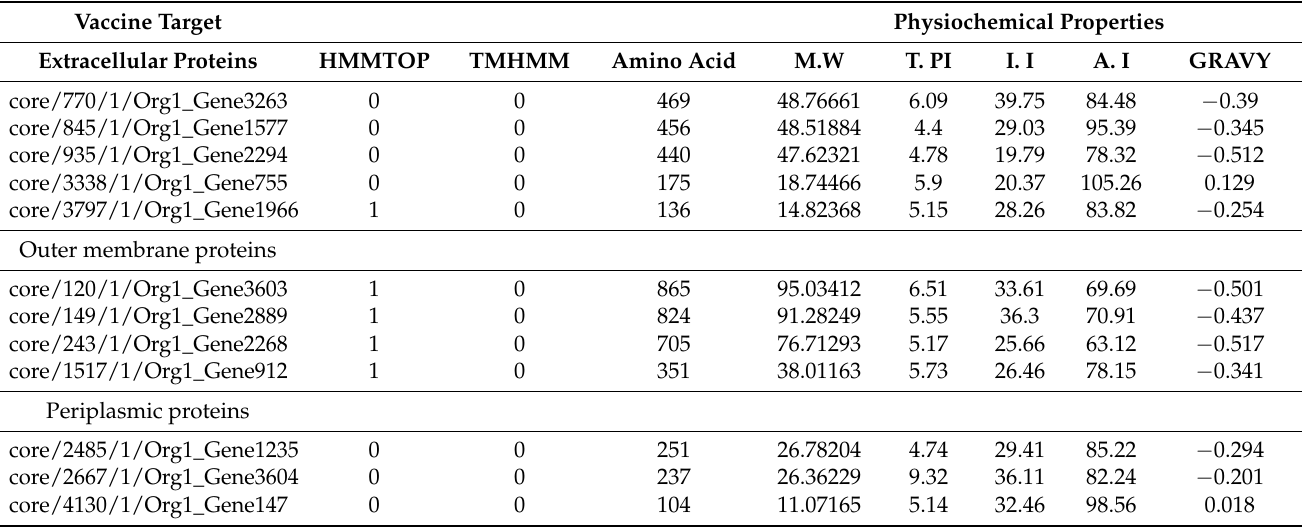
Table 3. Shows us the physicochemical analysis of virulent proteins including the transmembrane helices (TMH), amino acid number, the theoretical index (TI), molecular weight (MW), aliphatic index (AI), instability index (II) and GRAVY.